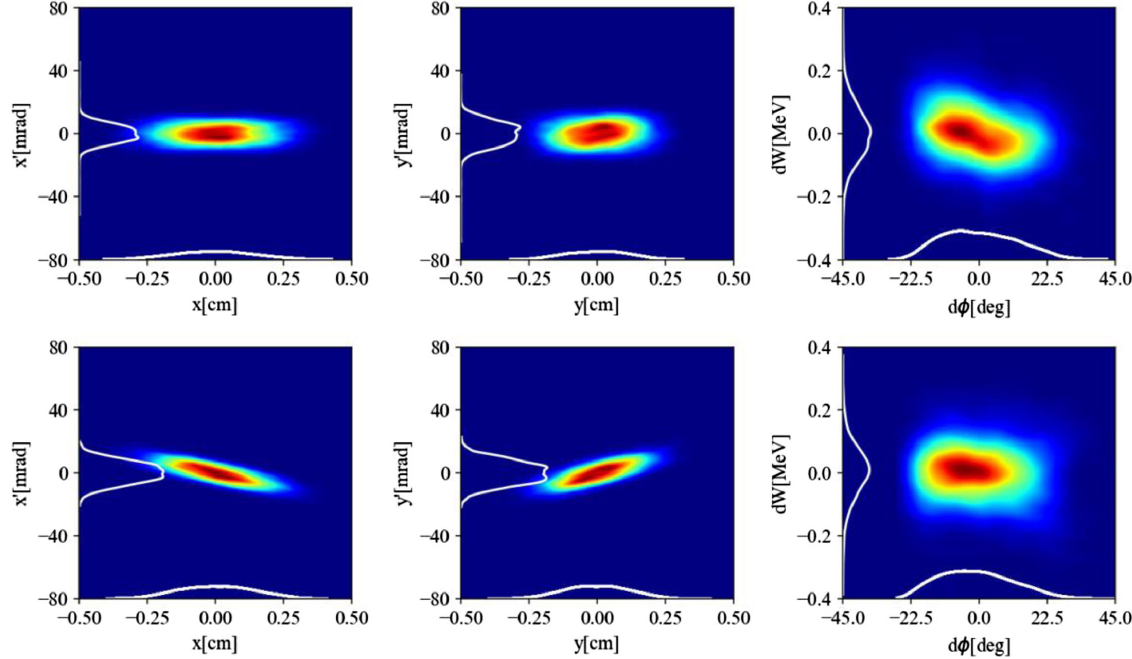
FIG. 6. Particle distributions at the RFQ 1 output (top graphs) and at the RFQ 2 output (bottom